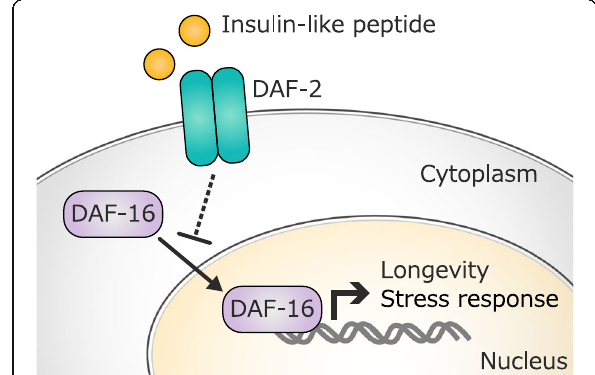
Fig. 1 Schematic diagram of the IIS pathway-mediated longevity in C. elegans . Under reduced IIS, DAF-16 is translocated to the nucleus and activates the transcription of pro-longevity